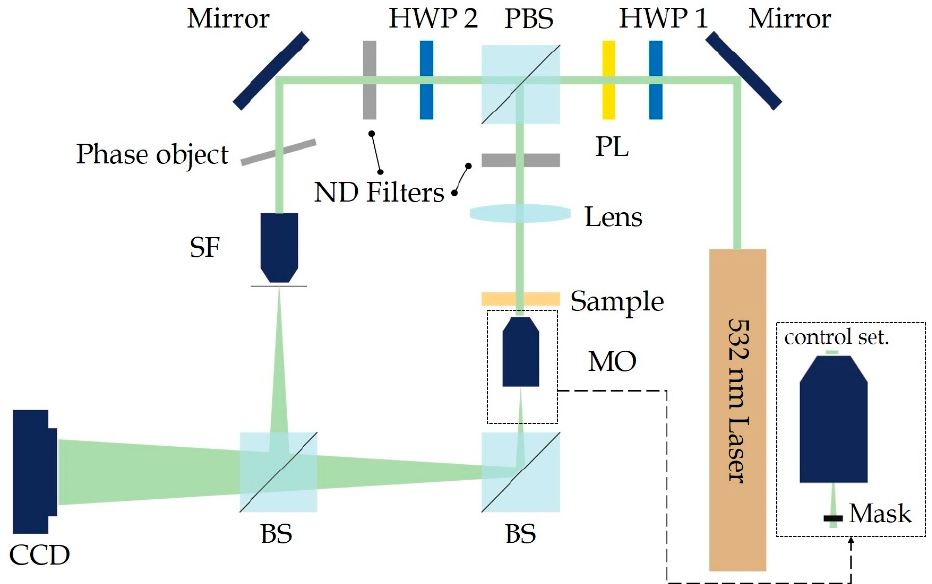
Figure 1. Schematic of the IDFDHM experimental setup. IDFDHM is based on two techniques that we developed previously: arbitrary micro- phase shifting [8] and virtual lens compensation [7]. The virtual lens compensation technique suppresses the quadratic phase term by using two waves that have the same quadratic phase term. This is achieved by simply employing two identical microscope objective lenses in each arm. Let ψ , a , ϕ , λ , and R represent the light field, amplitude, phase, wavelength, and radius of curvature, respectively, while the subscripts O and R denote the qualities associated with the object wave and reference wave, respectively, as expressed in Equations (1) and (2). Upon interference, the quadratic phase terms (including phase aberrations) cancel each other out, and the interference pattern I H is the result of the interference of two plane waves, as expressed in Equation (3).